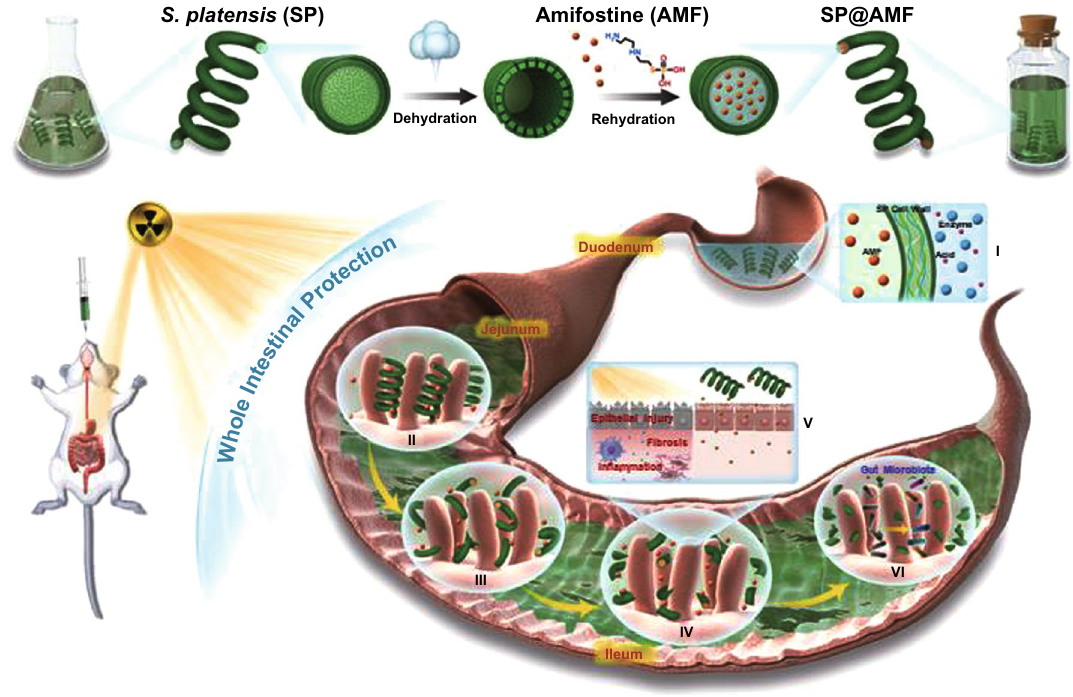
Fig. 12 Schematic illustration of upgradation of SP@AMF and its radioprotective mechanisms. I. Schematic illustration of the mechanism how SP protects AMF from gastric destruction. II–IV. Schematic illustration of the controlled releases AMF form the upgraded SP@AMF when traveling along the small intestine. V. Schematic illustration of the protection of SP@AMF from radiation-induced epithelial injury, inflamma- tion, and fibrosis. VI. Schematic illustration of SP@AMF for maintaining the health of gut microbiota [267]. (Reprint with permission from Nature Publishing